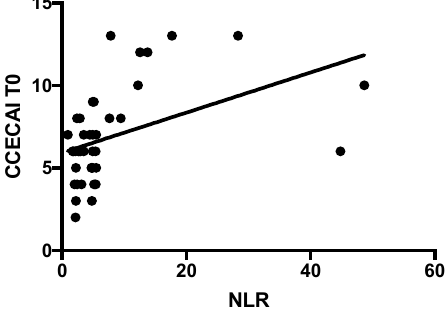
Figure 2. Correlation between NLR and canine chronic enteropathy clinical activity index (CCECAI) score at the admission ( p = 0.0004; r = 0.528).